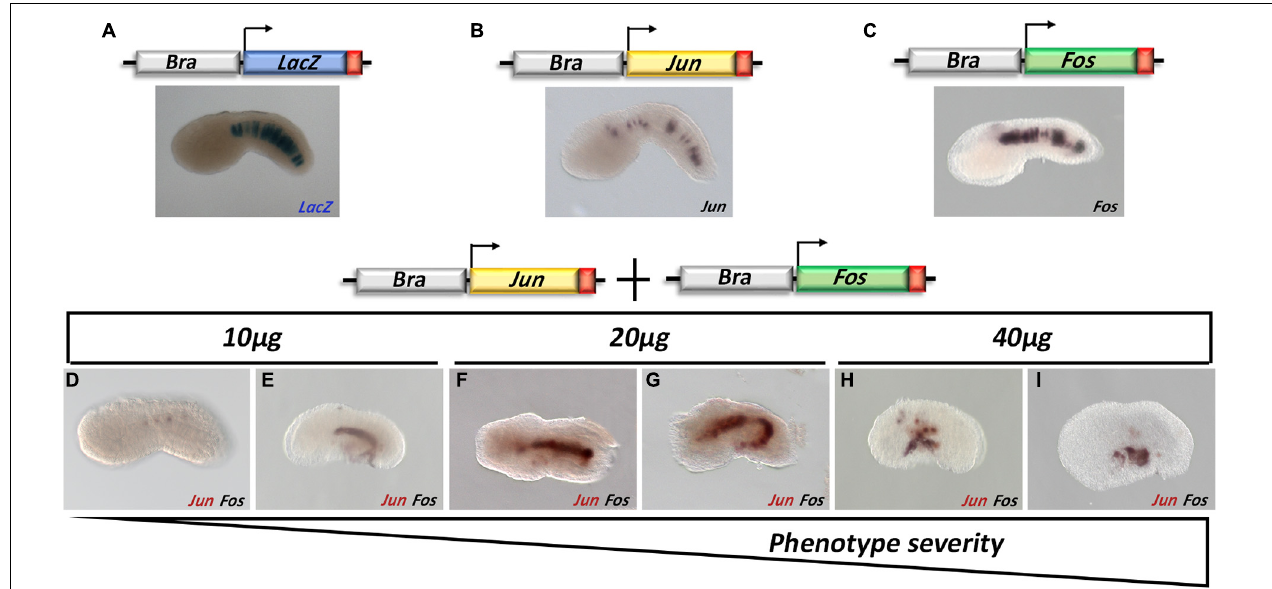
FIGURE 3 | Functional analysis of Jun and Fos during Ciona robusta development. (A) Brachyury promoter (Bra) specifically drives the expression of a transgene in the notochord cells; fertilized eggs electroporated with Bra > LacZ (A) , Bra > Jun (B) , and Bra > Fos (C) and reared up to the mid tailbud I stage (S21) were checked for the transgene expression through β -galactosidase assay staining (Bra > LacZ ) or whole-mount in situ hybridization (WISH) using Jun (brown staining)- and Fos (black staining)-specific probes. (D–I) Jun and Fos double WISH on tailbud embryos co-electroporated with Bra > Jun and Bra > Fos . Increasing amounts of Bra > Jun and Bra > Fos go at the same pace with the growing severity of the phenotype; double WISH experiments show that the transgenes are less expressed in the most wt-like embryos (D) . For all embryos, the anterior is on the left and the dorsal on the top.